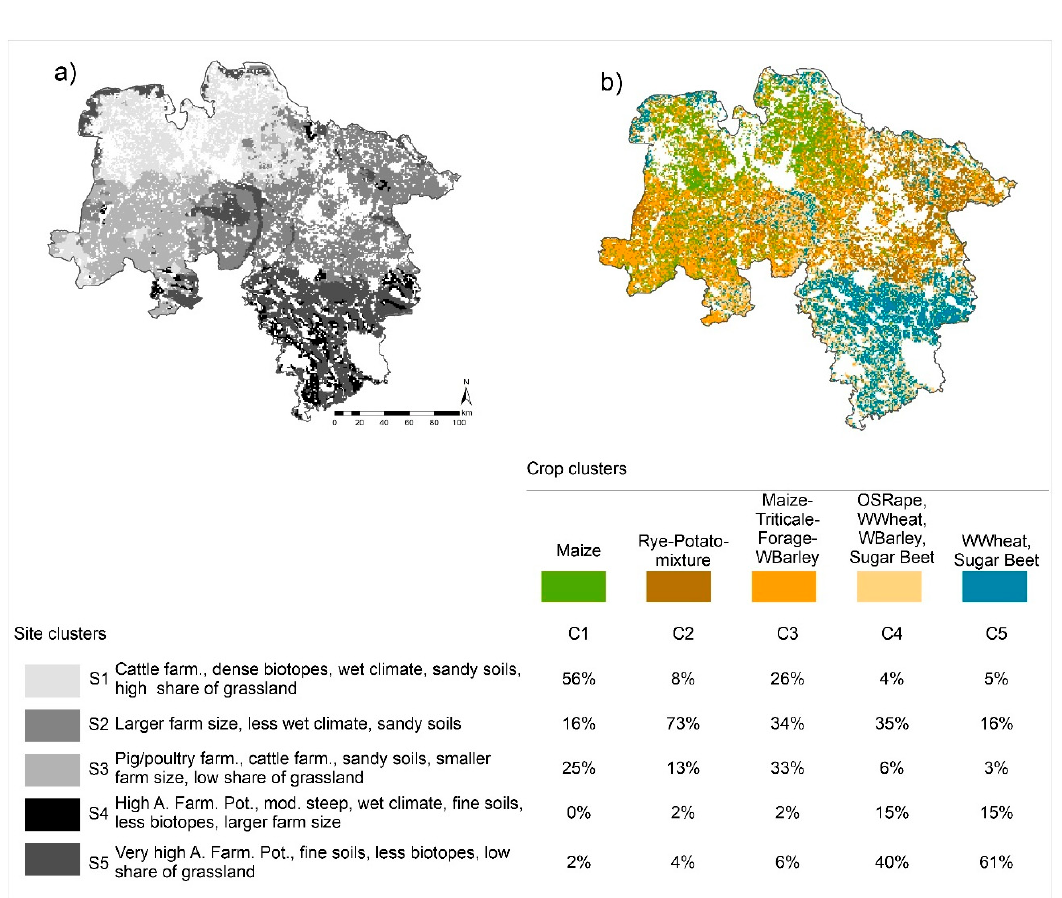
9 of 15 Table 5. Mean values of the k-means clustering of crop data (corresponding map in Figure 3b). The values represent mean ratios of the crop area per arable area of the related quadrant. Values in bold are significantly higher than the mean value of the certain crop and are considered characteristic crops for the cluster type. C1